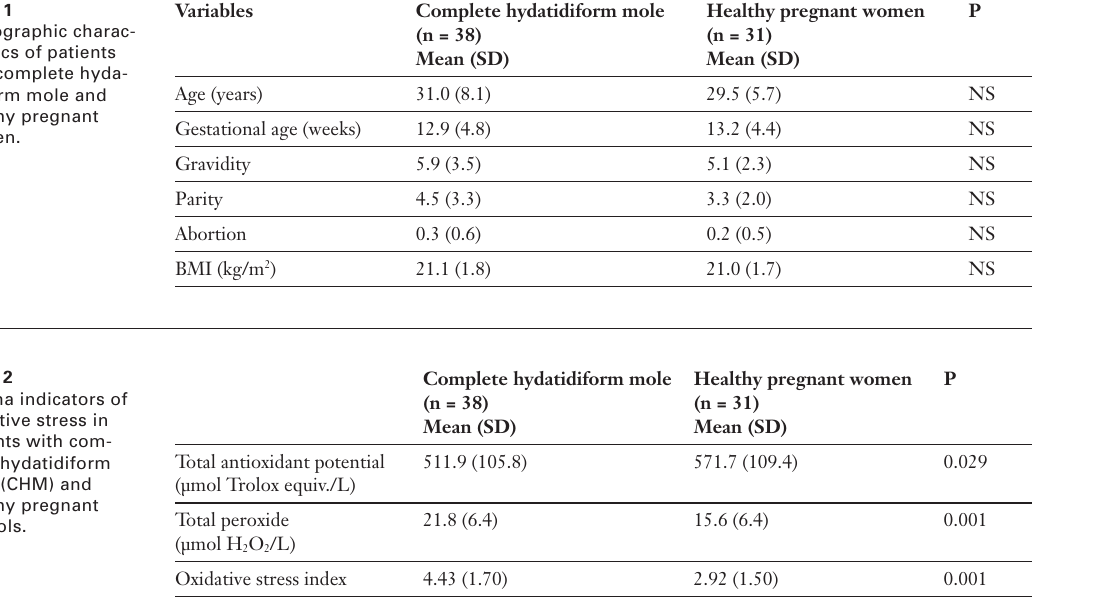
Table 1 Demographic charac- teristics of patients with complete hyda- tidiform mole and healthy pregnant women.